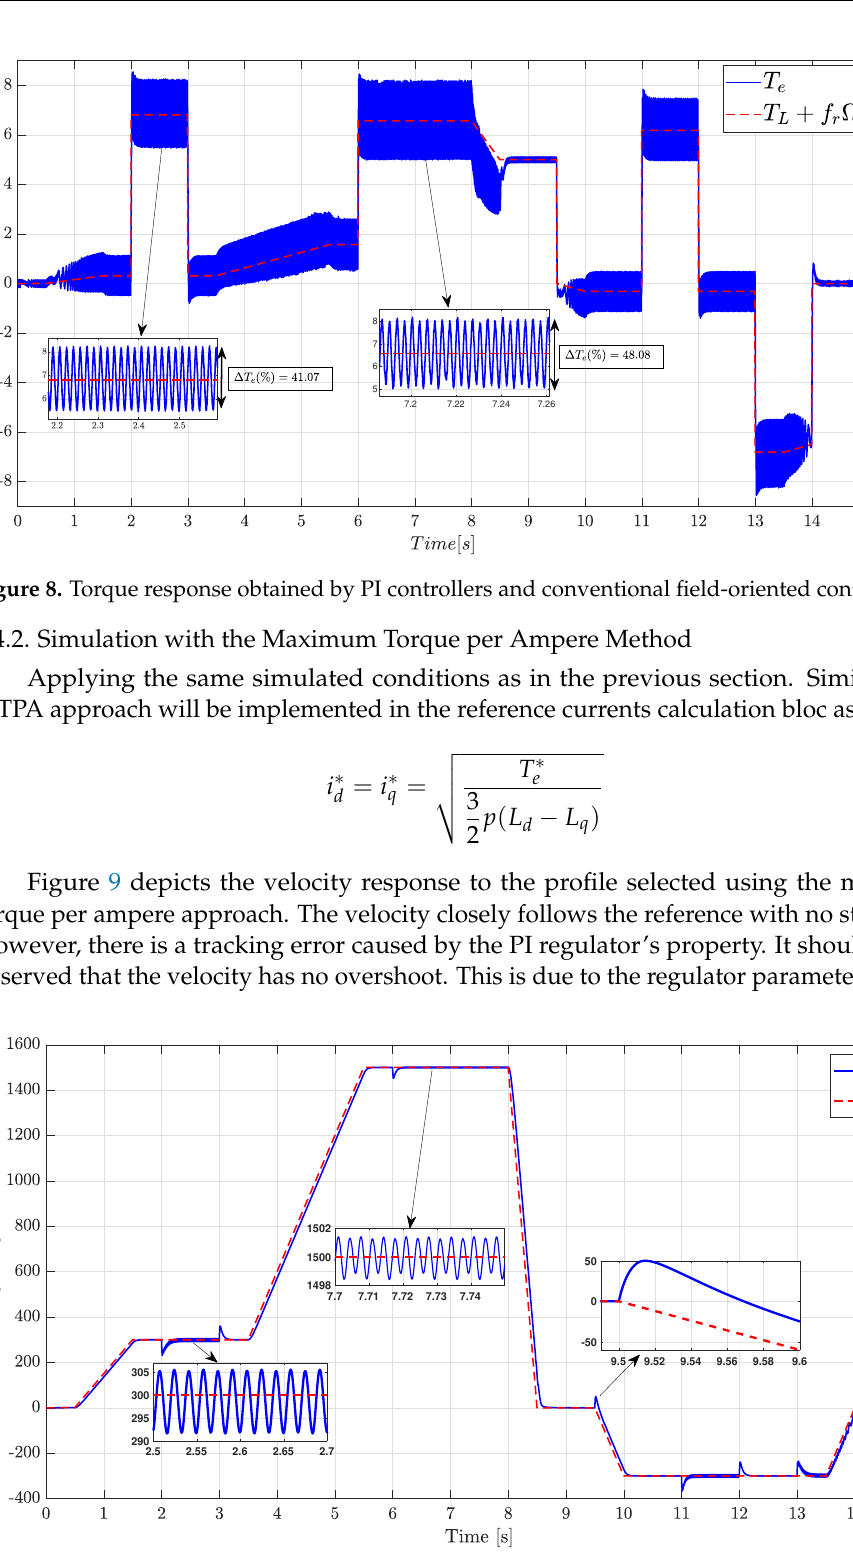
Figure 9. Velocity response obtained by PI controllers and maximum torque per ampere